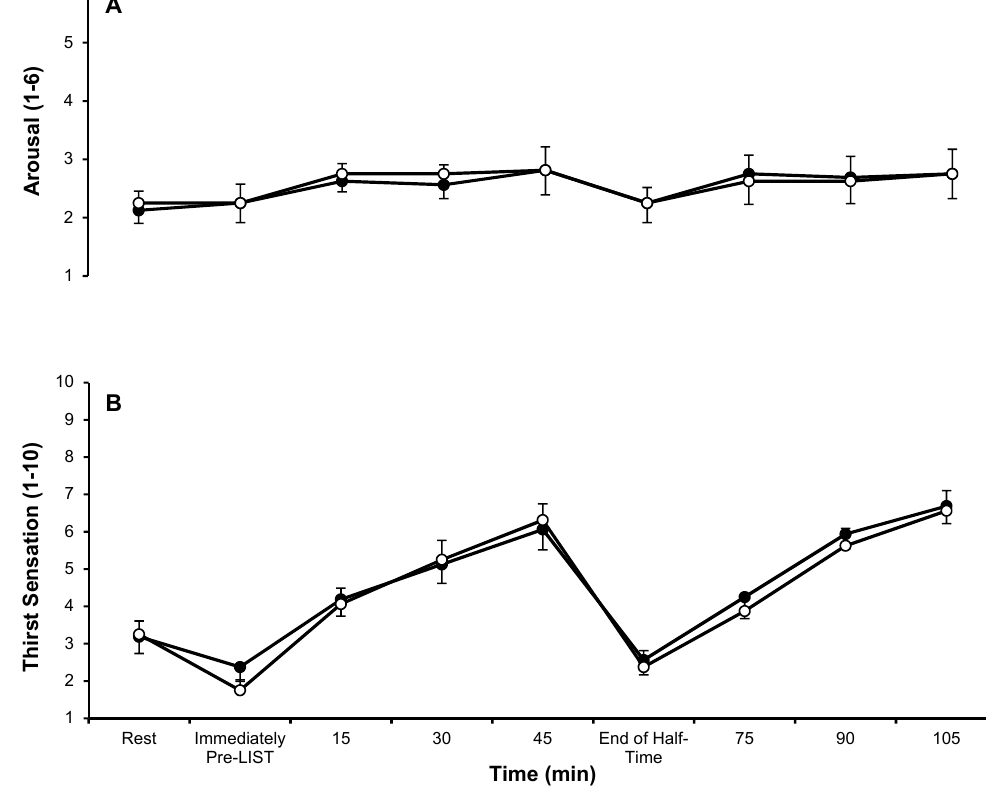
Figure 3. Subjective feelings questionnaires for ( A ) arousal (1 = low arousal; 6 = high arousal) and ( B ) thirst sensation (1 = not at all; 10 = very, very much) during CHO ( ) and PLA ( mean ± SE. CHO: carbohydrate trial; PLA placebo